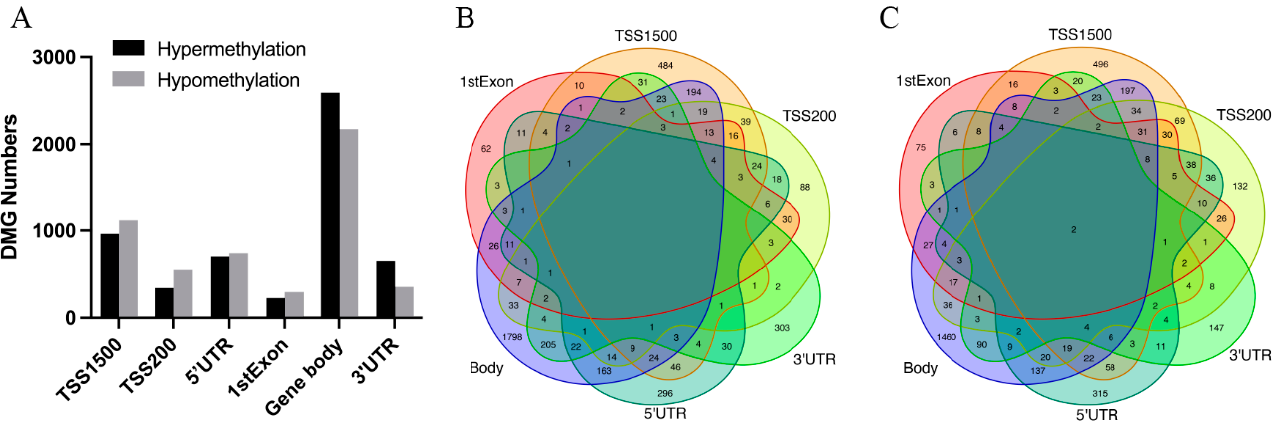
Figure 3. Integration analysis results of DMGs based on different region CpGs. ( A ) Bar plot of hypermethylated DMGs and hypomethylated DMGs in each region. Venn plot for ( B ) hypermethylated DMGs and ( C ) hypomethylated DMGs in different regions. The numbers on the diagram represent the DMG numbers in a specific region or multiple regions. Each region name is labeled beside the region circle.